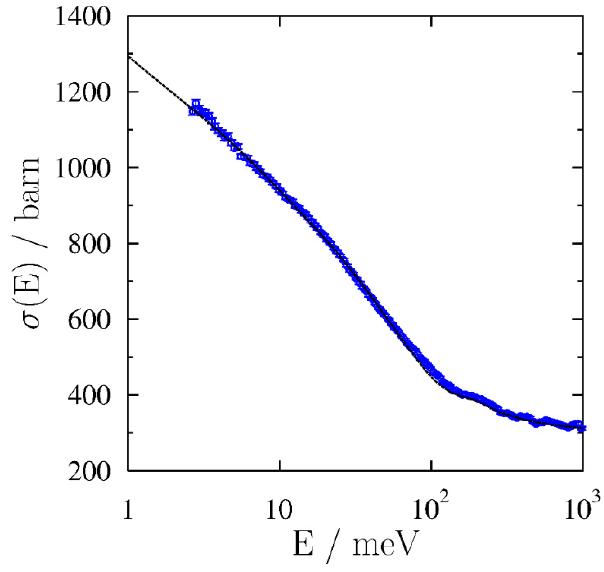
Figure 9. The total neutron scattering curve, recorded as a function of the incident neutron energy for the sample of rice pasta with the water content 0.1069 g/g d.m. at 40 ◦ C together with the prediction from the AFGA model. The experimental data are shown as blue markers and the AFGA model prediction as a dashed black line.